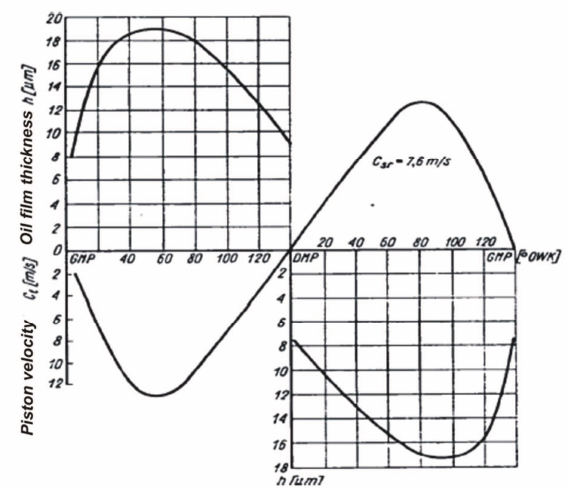
Fig. 1. The minimal oil film thickness by piston ring-cylinder wall system and the crankshaft position